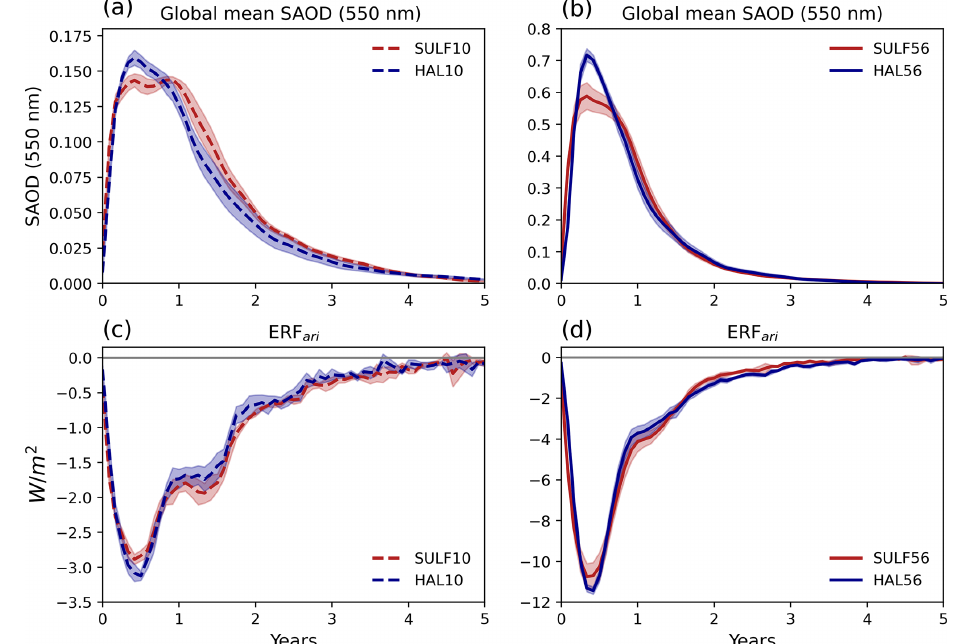
Figure 4. Global-mean evolution of the stratospheric aerosol optical depth anomaly at 550nm: (a) SULF10 and HAL10; (b) SULF56 and HAL56. Global-mean evolution of top-of-atmosphere global-mean ERF ari : (c) SULF10 and HAL10; (d) SULF56 and HAL56. Shading represents the ensemble